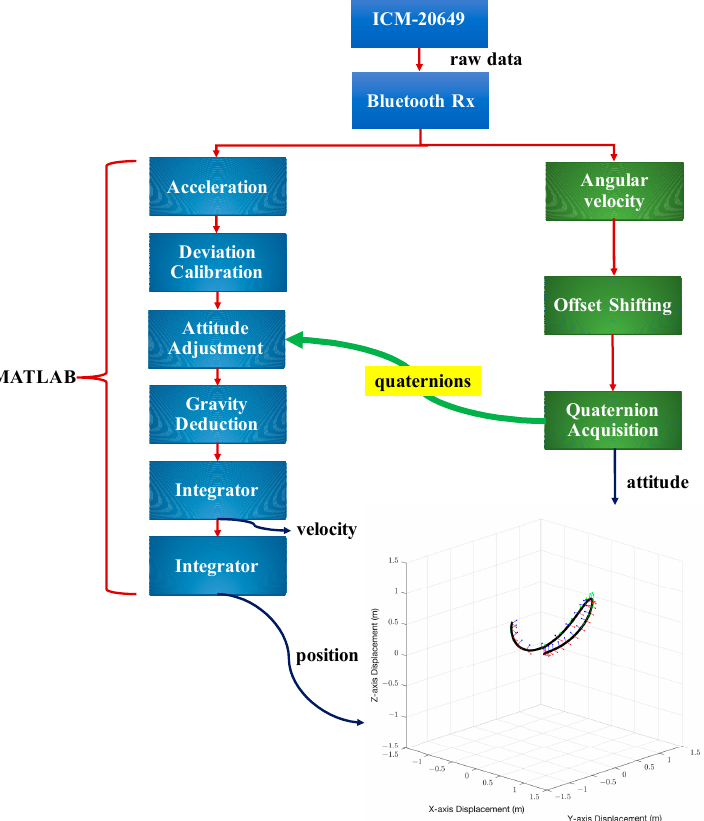
Figure 1. An illustration of the proposed system. The three colored small axes on the trajectory represent the coordinates of the sensor.